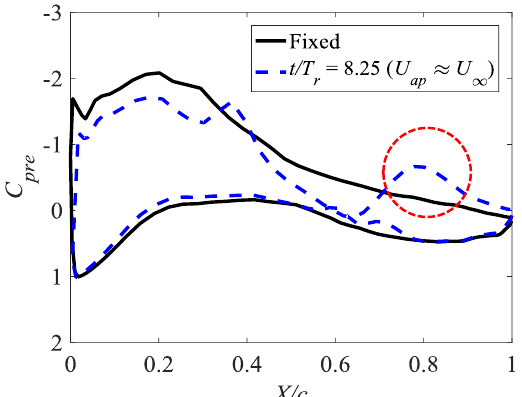
Fig. 10. Instantaneous pressure coefficient distribution at blade cross-section r/R = 0.8 for fixed (solid) and surging (dashed) turbines at 𝑡 𝑇 𝑟 ⁄ = 8.25, where 𝑈 𝑎𝑝 ≈ 𝑈 ∞